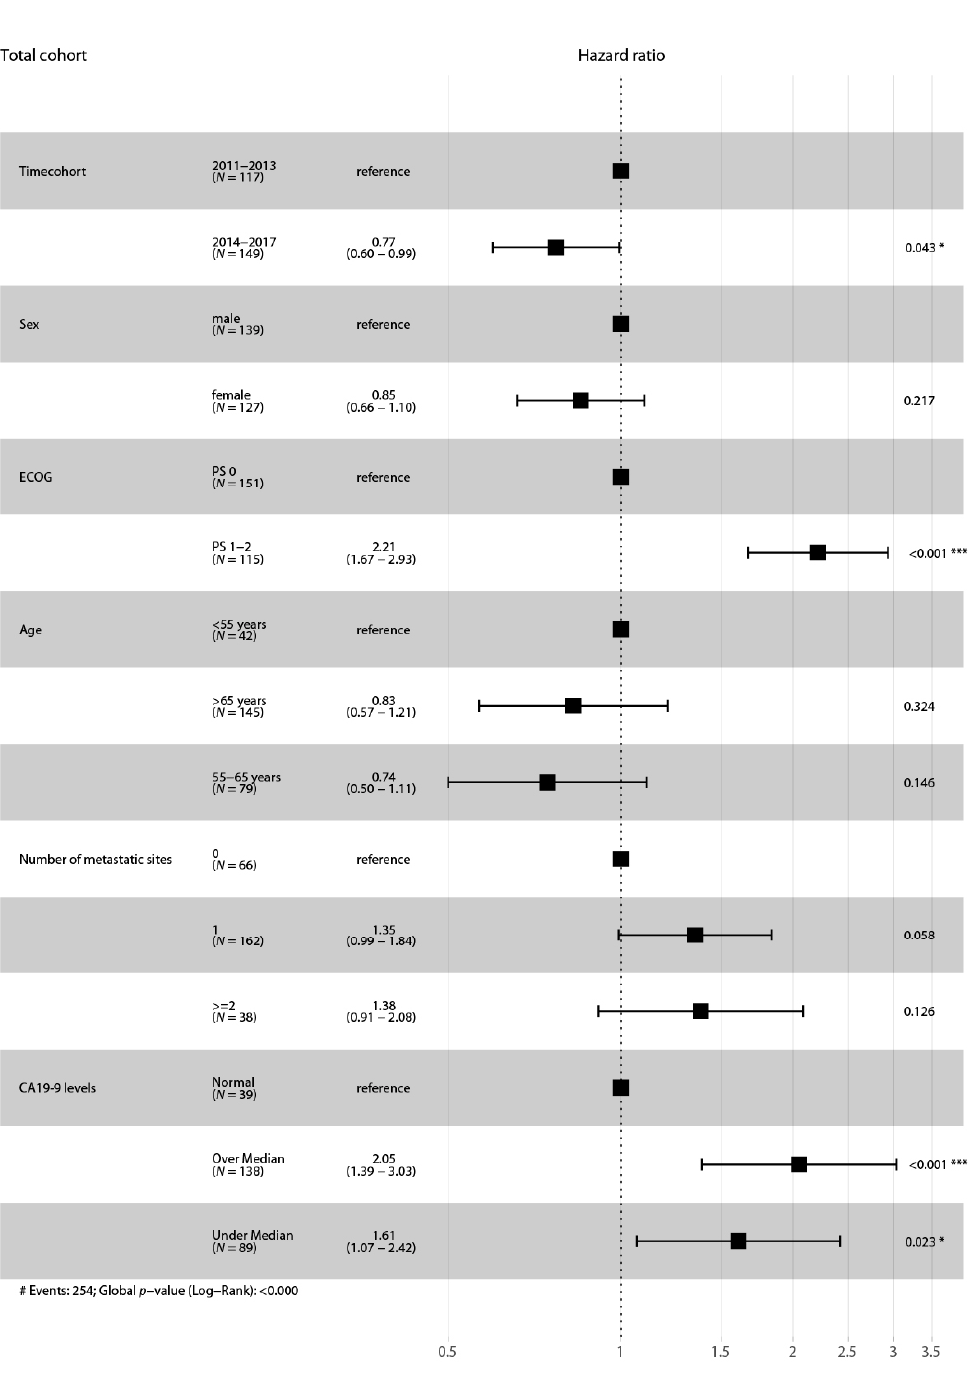
Figure 3. Forest plot for the adjusted survival analysis for all patients. Cox proportional hazard model to analyze the effect of multiple variables on the survival outcome of all patients. Abbreviations: ECOG, Eastern Cooperative Oncology Group performance scale. N = 266 (patients with missing values of variables were excluded from the analysis). Asterisks indicate p -value, * 0.01 to 0.05, ** 0.001 to 0.01, *** 0.0001 to 0.001. # indicates number.